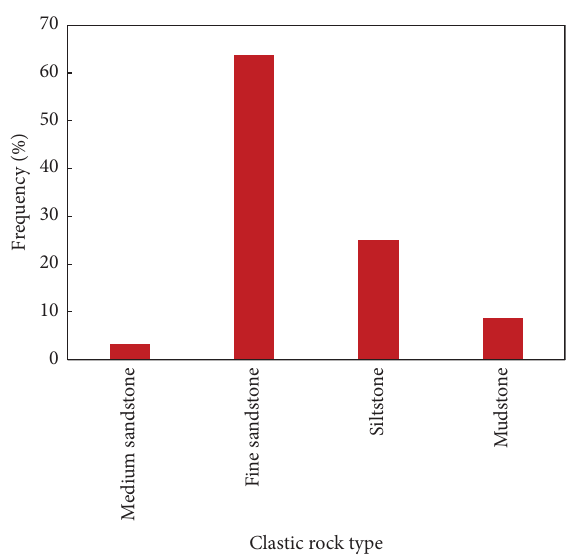
Figure 2: Main clastic rock types of long 6 segments of Yanchang